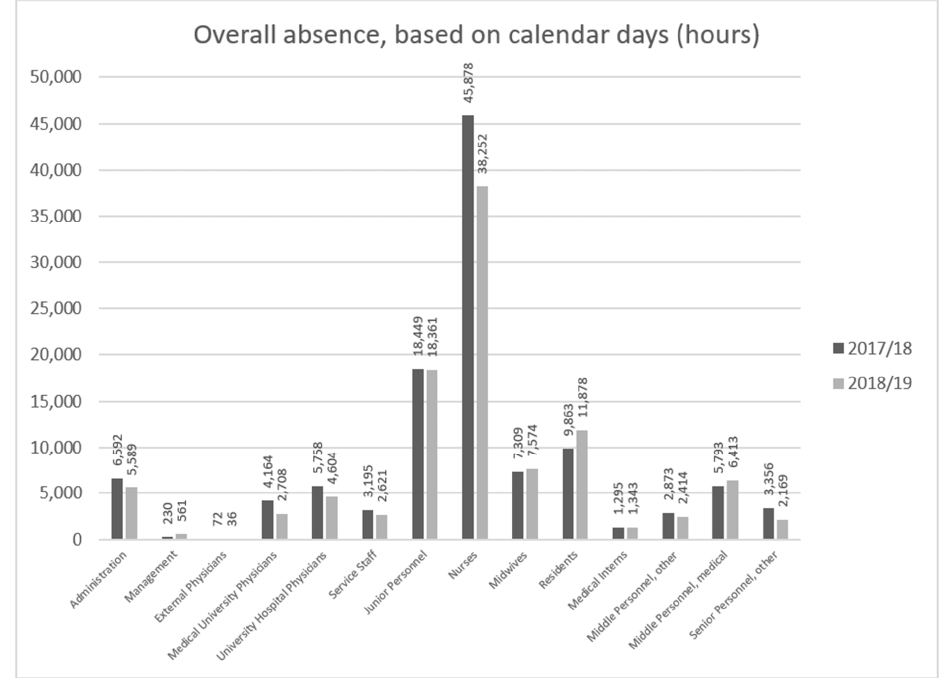
Figure 4. Overall lost working days among the hospital employees with absence due to illness reported during the 2017–2018 and 2018–2019 flu seasons, by healthcare professional group. However, the largest loss of working hours among nurses was not the result of the longer flu duration among the nursing staff compared to among other occupational groups (Figure 5).